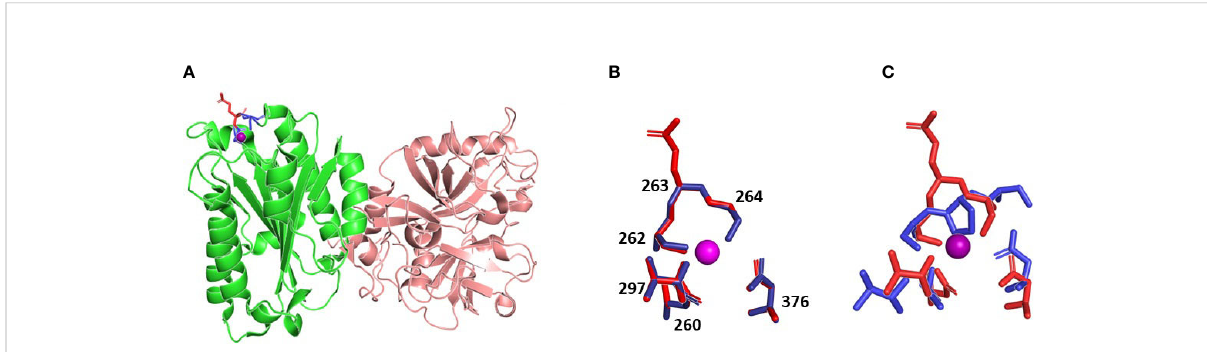
FIGURE 4 The three-dimensional models of C2 variants with Q263P and Q263G substitution. (A) Structure of WT C2 protein (PDB ID 2I6Q), C2a fragment indicated in green, amino acids forming MIDAS motif indicated in blue, Gln 263 indicated in red, metal ion is shown as violet sphere. (B) overlapping MIDAS motif residues with its numbers for WT protein (red) and model of Q263G variant (blue), metal ion is shown as violet sphere. (C) overlapping MIDAS motif residues for WT protein (red) and model of Q263P variant (blue), metal ion is shown as violet sphere. MIDAS motif is shown in the same orientation as on panel B.